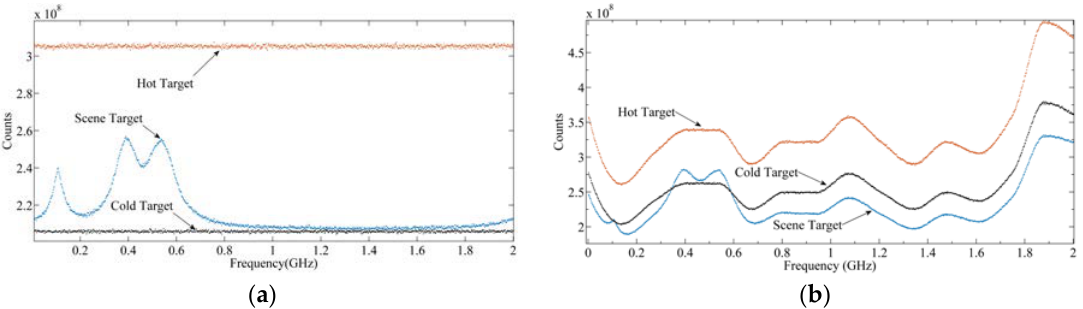
Figure 10. The output signal of the backend under the integration time of 100 ms: ( a ) SRF is a rectangular function; ( b ) SRF is not ideal.